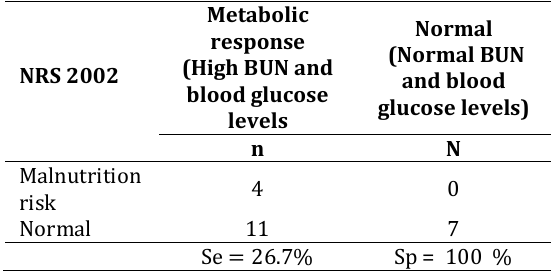
Table 4. The results of the test validity (specificity and sensitivity) on the use of the